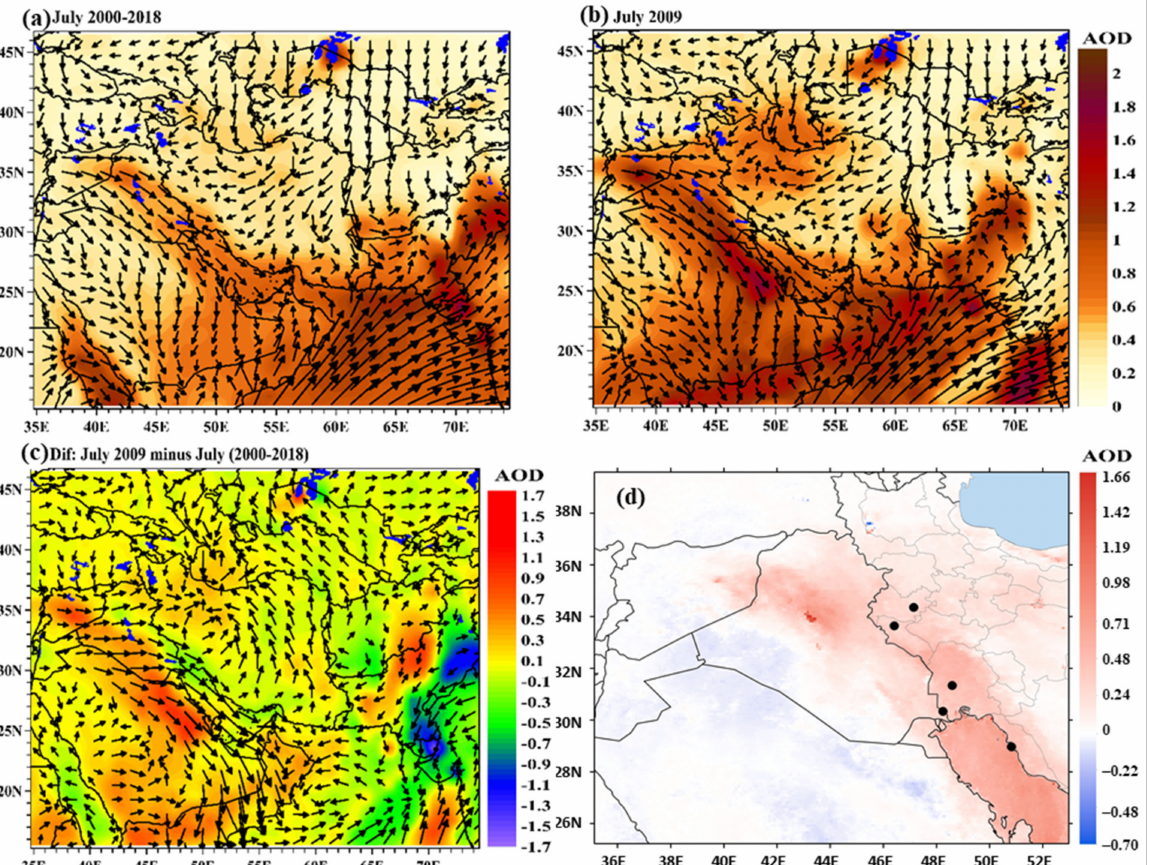
Figure 9. Spatial distribution of Terra-MODIS L3 AOD over the Middle East, south, and central Asia during July 2000–2018 ( a ), July 2009 ( b ) and the difference ( c ). Superimposed vector winds correspond to wind regime over each period and the difference. MODIS level 2 (10 km × 10 km) AOD differences are observed in ( d ) with an emphasis over the study region. Black dots show the five examined stations in southwest